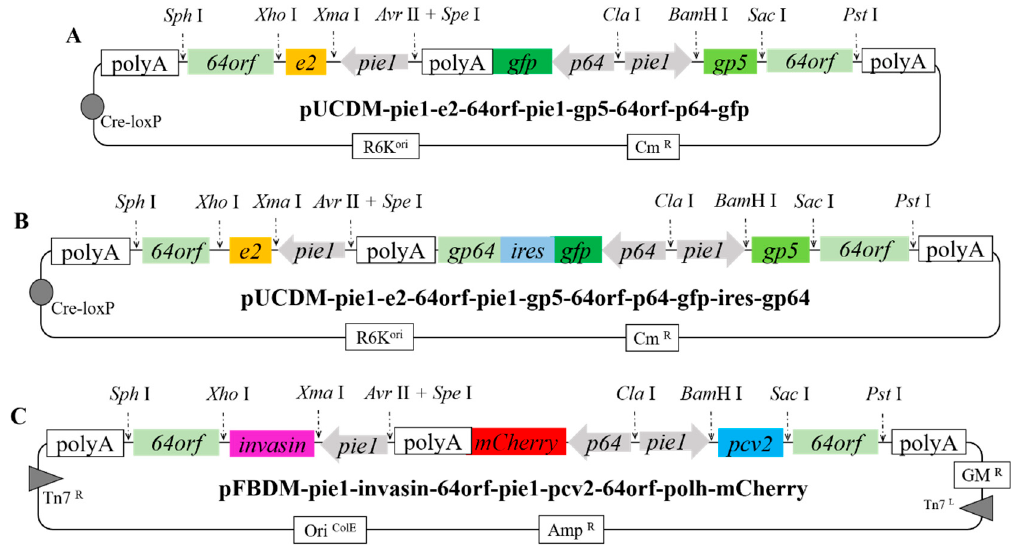
Figure 3. Construction of recombinant plasmids carrying antigen fusion genes. Four target genes ( e2 , gp5 , pcv2, and invasin ) were, respectively, fused with the membrane gene 64orf to realize the display of the fused protein on the surface of the recombinant baculovirus envelope. ( A ) The